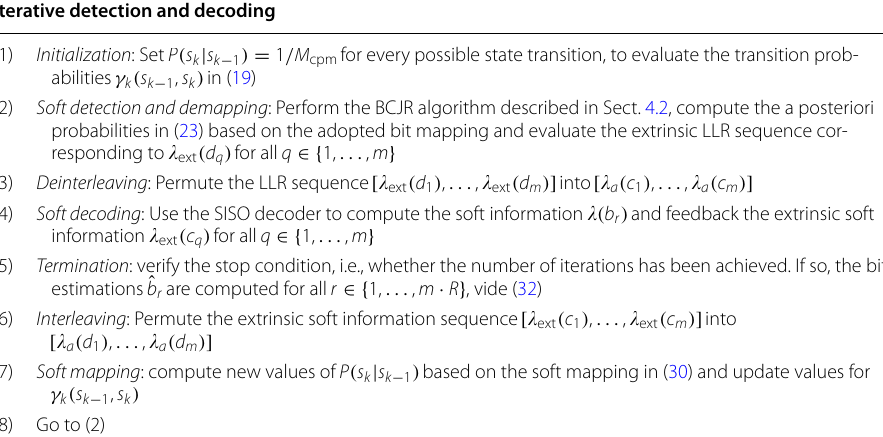
Table 1 Iterative detection and decoding algorithm steps Iterative detection and